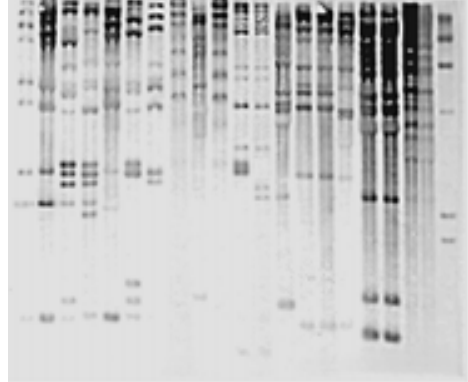
Figure 1 - Sma I ribotypes of